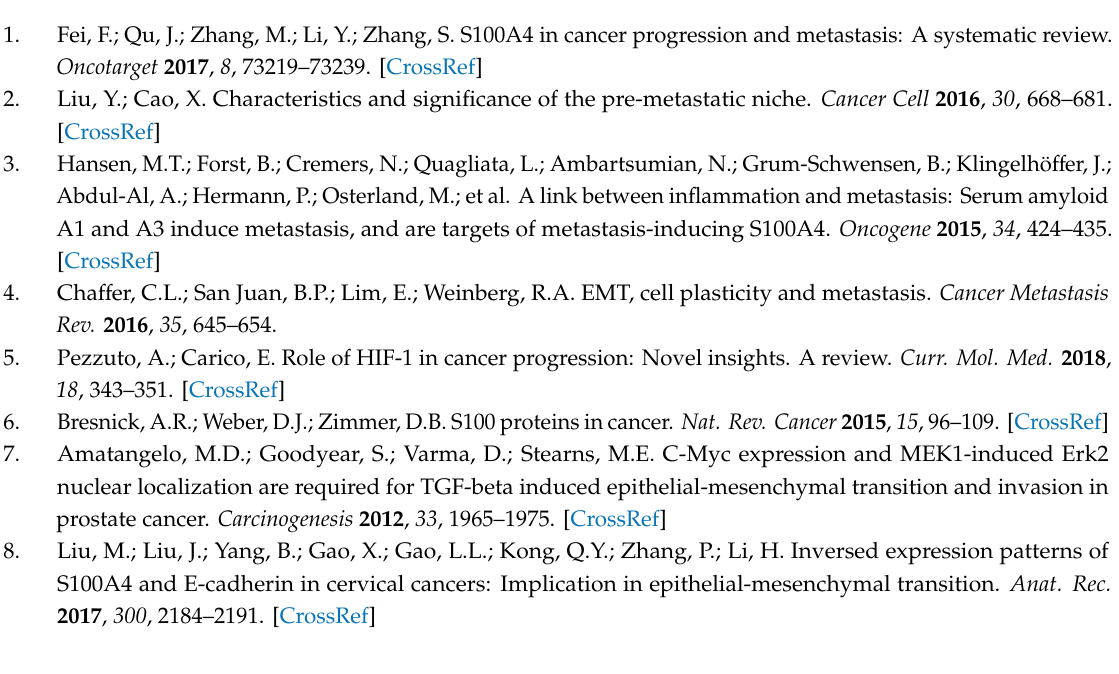
Figure S1: Comparative proteomic abundances of EMT markers in the di ff erent groups and subgroups of rat mesothelial cell lines, described in Table 1. Figure S2: Evolution of proteomic abundances for the 12 additional major candidate biomarkers (complement to S100A4 shown in Figure 1C). Figure S3: Sections of each human MM tumor histological subtype, stained with HPS. Figure S4: Proteomic abundances of protein S-100A4 and EMT markers in human MM tumor samples (data extracted from Supplementary Table S1). Figure S5: Illustration of the impact of protein S-100A4 expression on survival probability for patients with renal cancer (The human protein atlas / Pathology atlas). Figure S6: M5-T1 rat mesothelioma tumor cells invading secondary organs and tissues. Figure S7: Comparative abundances of additional S100 proteins detected in rat mesothelial cell lines and tumors. Table S1: Comparative SWATH-MS analysis of human pleural malignant mesotheliomas (sarcomatoid vs.